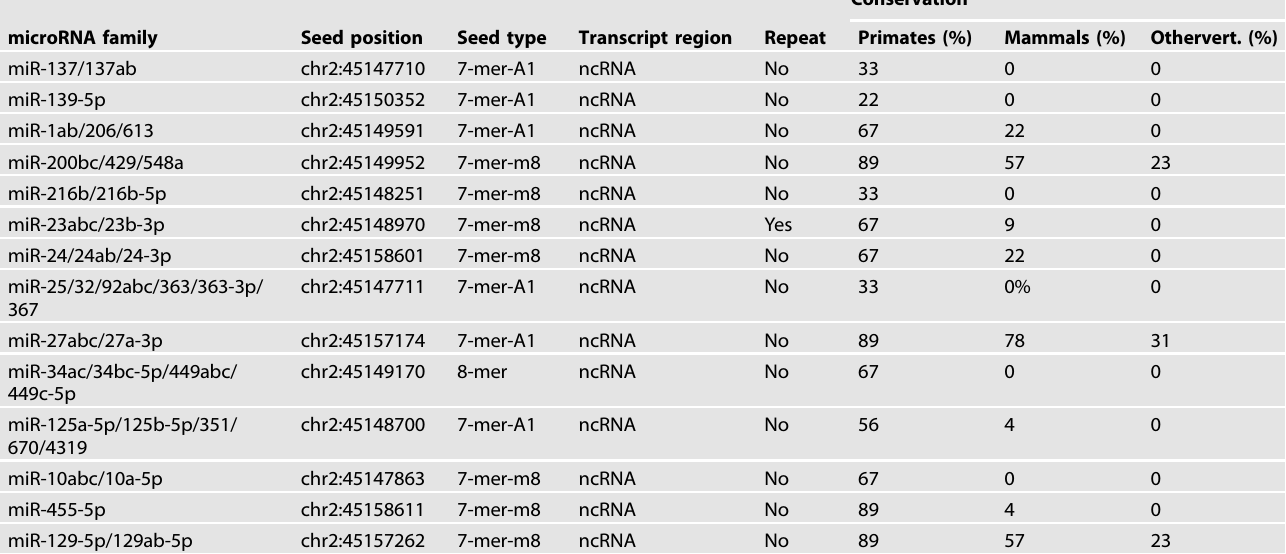
Table 2. Prediction of downstream miRNAs regulated by RP11-89 in miRcode